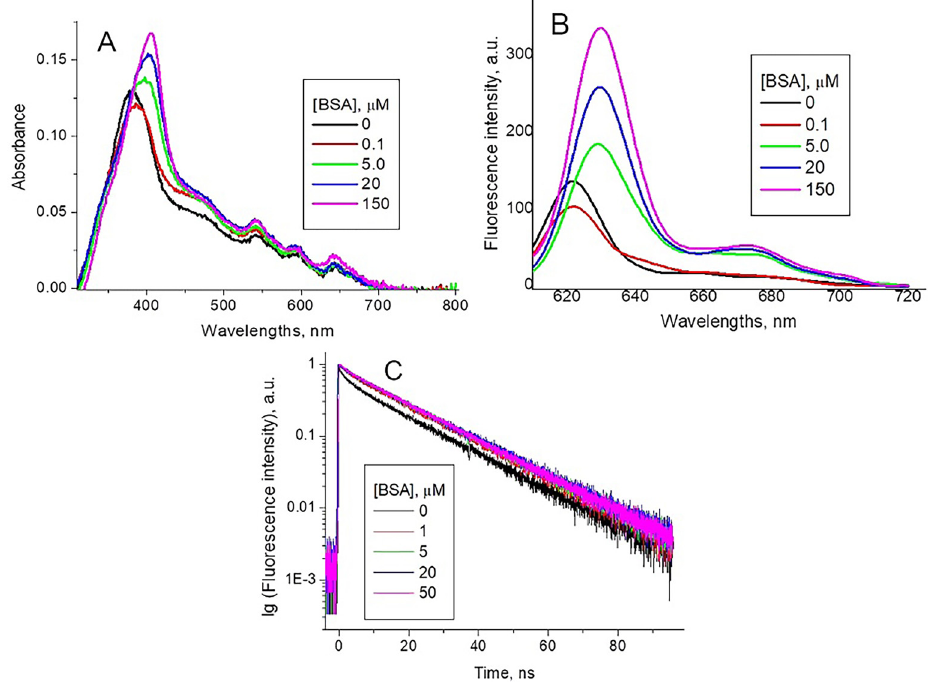
Figure 5. Optical absorption ( A ), fl uorescence ( B ) spectra, and fl uorescence decay curves ( C ) of 1.3 m M synthetic protoporphyrin IX (PpIXs) at pH 7.3 for different bovine serum albumin (BSA) concentrations ( l ex=420 nm, l em=628